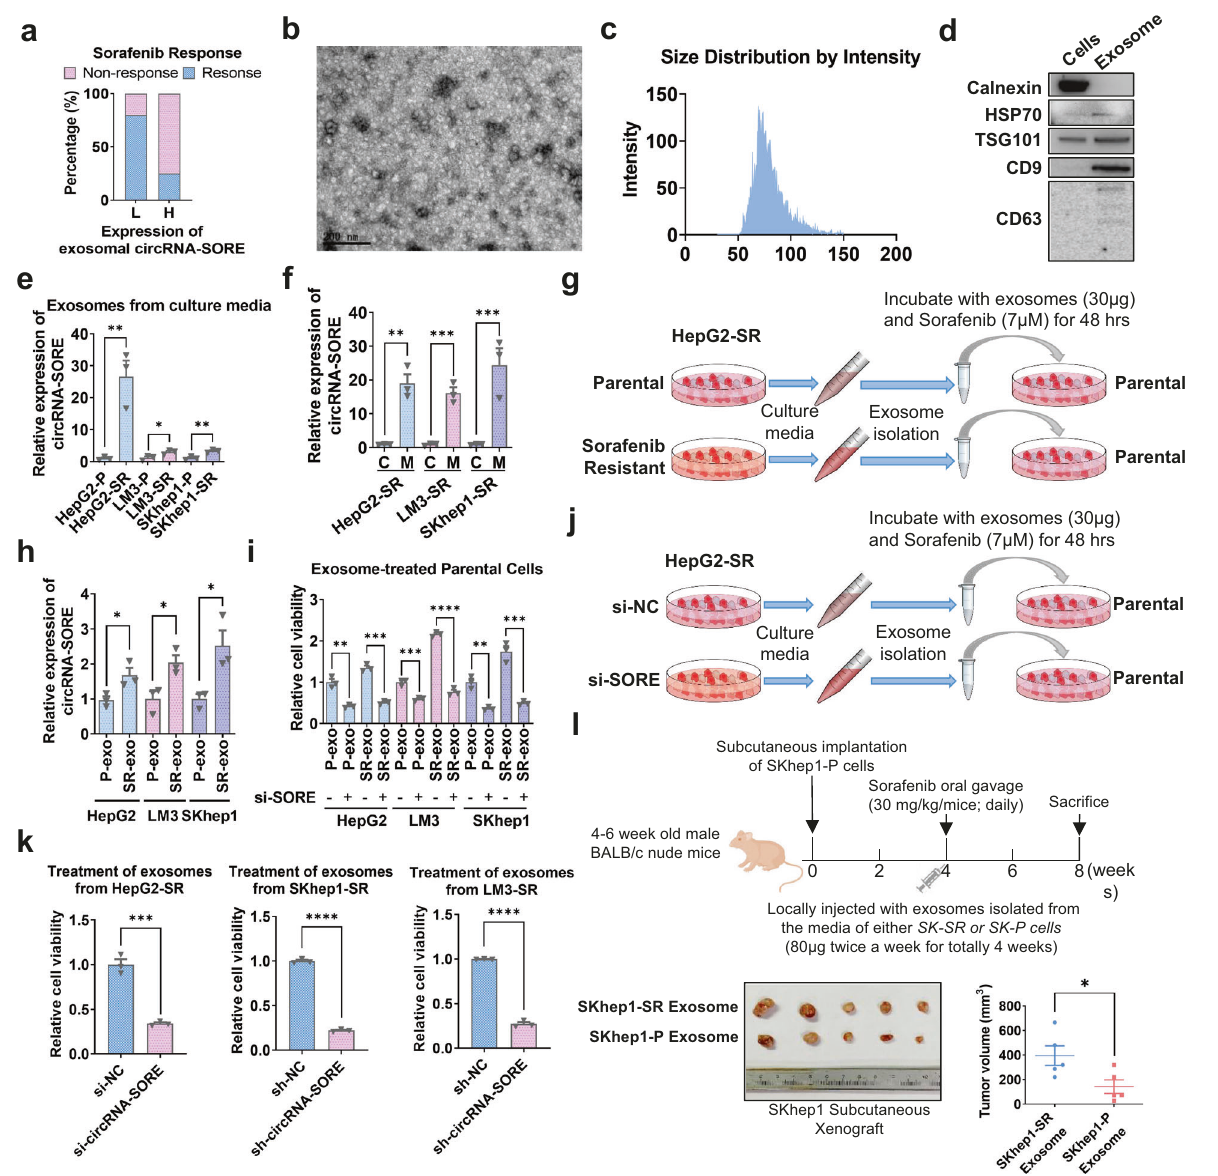
CircRNA-SORE transmits sorafenib resistance by exosomes. a Exosomes were extracted from the blood of nine HCC patients prior to sorafenib treatment, and exosomal circRNA-SORE expressions were evaluated by qPCR assays. Lower and higher circRNA-SORE expressions were strati fi ed by the average expression among the nine patients. Response to sorafenib was de fi ned as once achieved complete response, partial response or stable disease for >3 months. b Negative staining electron micrograph of exosomes isolated from HepG2-SR culture media. Scale bar, 200 nm. c Size distribution of exosomes by NanoSight NS300 instrument. d Western blot analysis for positive exosome markers (HSP70, TSG101, CD9 and CD63) and negative exosome marker (Calnexin). e qPCR analysis of exosomal circRNA-SORE isolated from sorafenib- resistant and parental cell culture media. f qPCR analysis of circRNA-SORE isolated from sorafenib-resistant cell culture media (M) and cells (C). g Schematic showing that exosomes were isolated from parental and sorafenib-resistant cells (P-exo and SR-exo, respectively) and used to treat (30 μ g) parental cells for 24 h. The exosome-treated parental cells were then transfected with si-NC or si-circRNA-SORE and treated with sorafenib for 48 h. h , i Exosomes were isolated from parental and sorafenib-resistant cells (P-exo and SR-exo, respectively) and used to treat parental cells for 24 h. The exosome-treated parental cells were then transfected with si-NC or si-circRNA-SORE and treated with sorafenib for 48 h. Charts show h qPCR results of circRNA-SORE expression and i cell viability in exosome-treated parental cells. j Schematic showing that HepG2-SR cells were treated with si-NC or si-circRNA-SORE before the culture media were harvested for exosome isolation and subsequent exosome treatments (30 μ g) on HepG2 parental cells. k HepG2-SR, SKhep1-SR and LM3-SR cells were treated with si-NC or si-circRNA-SORE before the culture media were harvested for exosome isolation and subsequent exosome treatments on parental cells. The chart shows the cell viability in exosome-treated parental cells. l BALB/c nude mice (4- to 6-week-old males) were subcutaneously injected with SKhep1-P cells. On week 4, the mice were treated with sorafenib (30 mg/kg/day) by oral gavage and exosomes (80 μ g twice a week for 4 weeks) from SKhep1- SR or SKhep1-P cell culture media by injection at the implantation site twice a week for 4 weeks. Animals were sacri fi ced on week 8 and xenografts were isolated and measured. Three independent experiments with three technical repetitions were performed. Data are expressed as mean ± SEM (error bars). Statistical analyses used Student ’ s t test. * p < 0.05, ** p < 0.01, *** p < 0.001 and **** p <